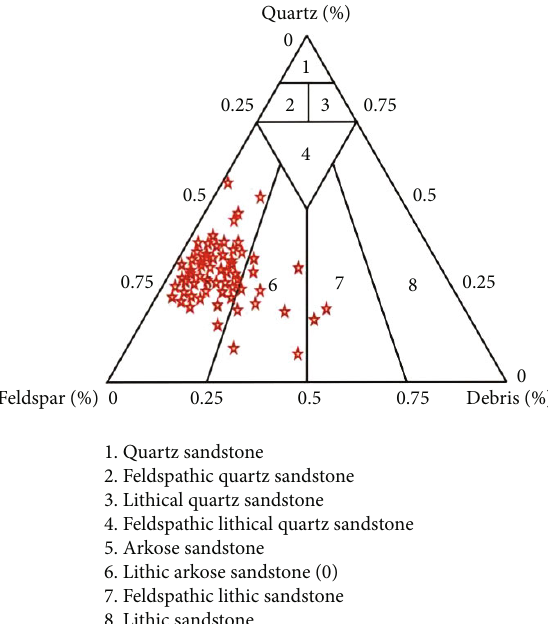
Figure 3: Triangle mapping of rock composition of Chang 6 Formation in Huaqing region of Ordos